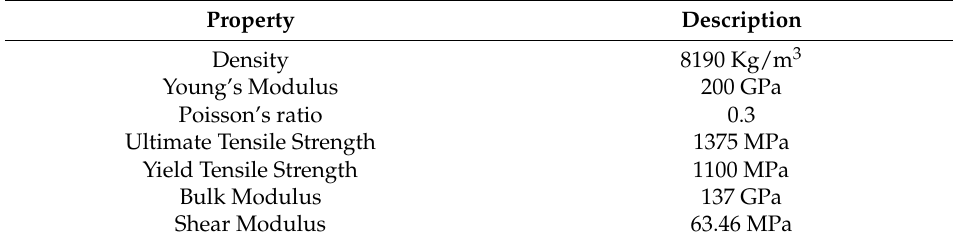
Table 3. Properties of Inconel 718 used in the modal analysis [56].